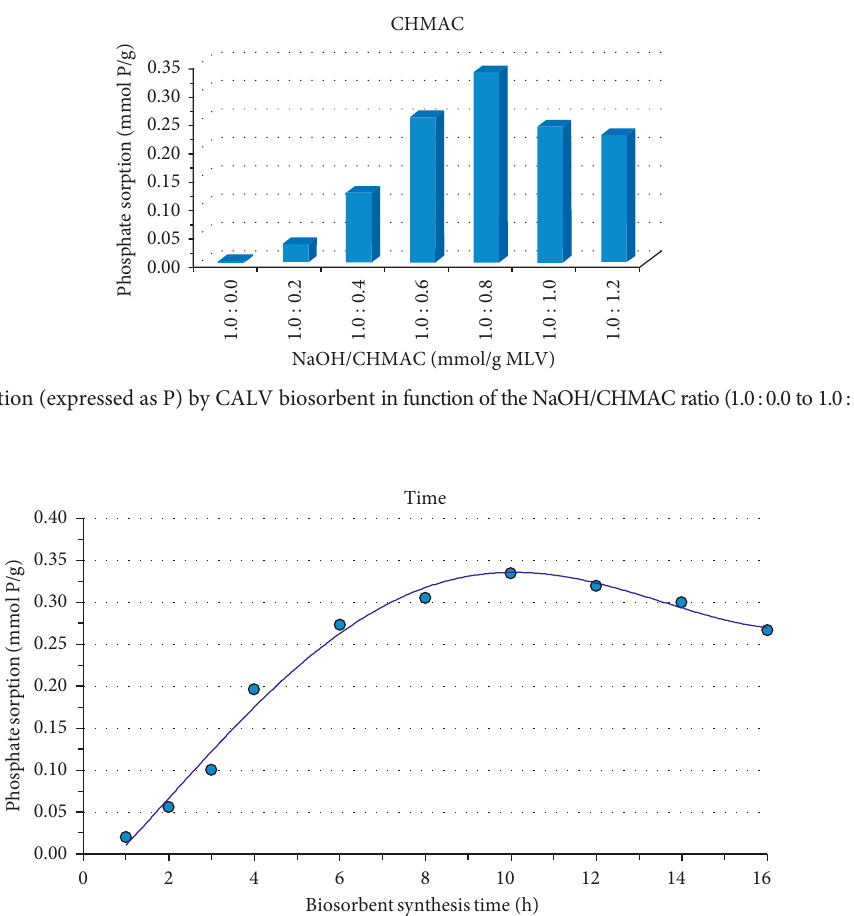
Figure 5: Phosphate sorption (expressed as P) by CALV biosorbent in the function of the synthesis time (1–16 h).